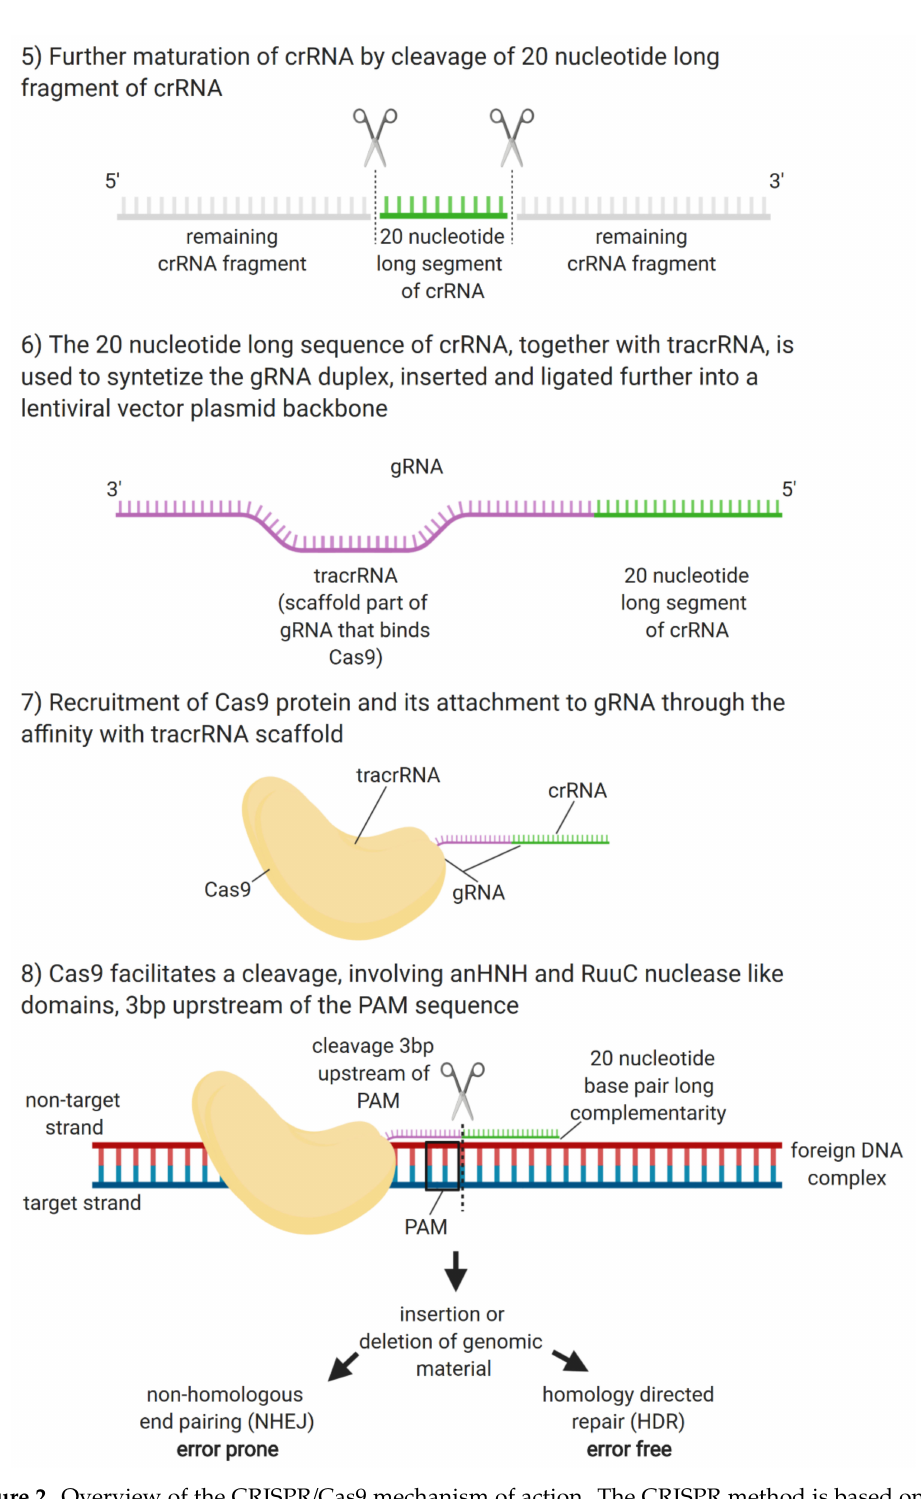
Figure 2. Overview of the CRISPR / Cas9 mechanism of action. The CRISPR method is based on the natural system used by bacteria to protect themselves from viral infections. When the bacteria detect the presence of viral DNA, they produce two short RNA sequences, one of which matches the sequence of the invading virus. These two RNAs form a complex with a protein called Cas9. Analogically, scientists firstly identify the gene causing a health problem, followed by the design of guide gRNA that recognizes that particular stretch of nucleotides. gRNA is attached to Cas9 nuclease and complex cuts DNA. At that point, researchers then edit an existing genome by modifying the leading strand or inserting foreign DNA